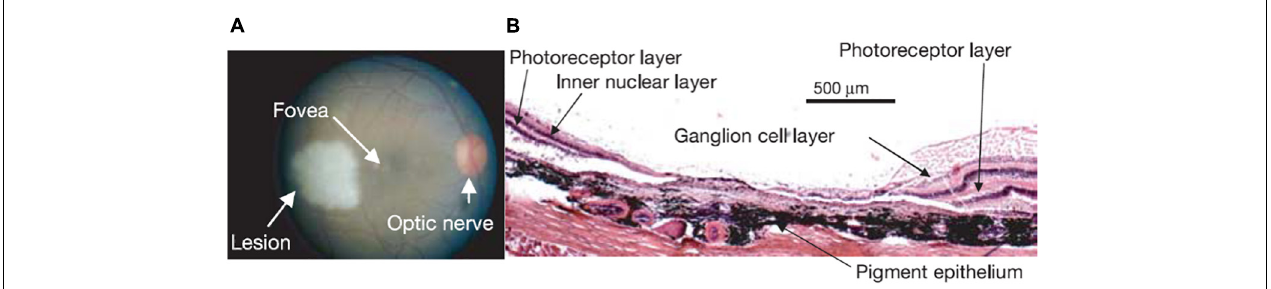
FIGURE 1 | (A) Retinal lesion. The right retinal fundus 1–2 h following photocoagulation. The lesion appears pale white. Note that a corresponding lesion was made on the other side of the fovea in the left eye resulting in a homonymous left visual field scotoma (data not shown). Visual stimulation was always presented monocularly, on the right eye for this monkey, thus avoiding activity changes that may be due to potential eye misalignment. (B) Haematoxylin-eosin stain of a 15 µ m thick section through the lesion in the right eye, where the visual stimulus was presented. Note the complete destruction of the photoreceptor layer, and the near complete destruction of the inner nuclear and ganglion cell layers (see Figure 1 in Smirnakis et al., 2005 for a full